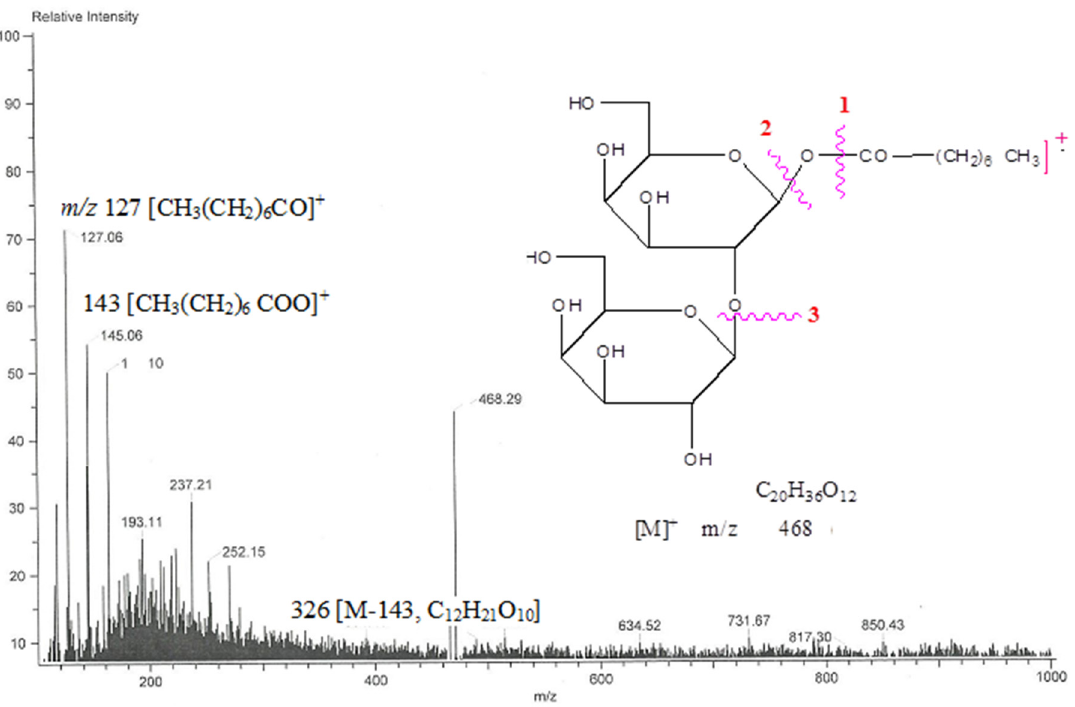
Figure 7. The diagnostic MS/MS fragmentation at m/z 792 full ESI-MS scan of the isolated compound n-octanoyl- β -D-glucopyranosyl-2 ′ - β -D-glucopyranoside.